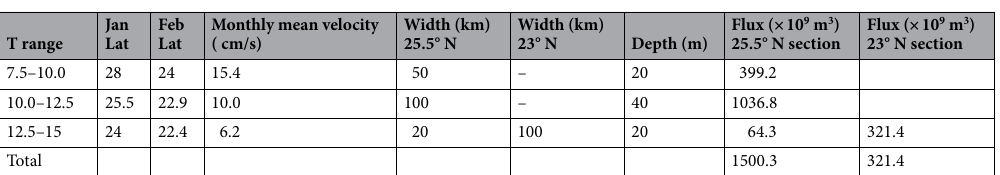
Table 1. Southward flux of seawater across 25.5° N and 23°